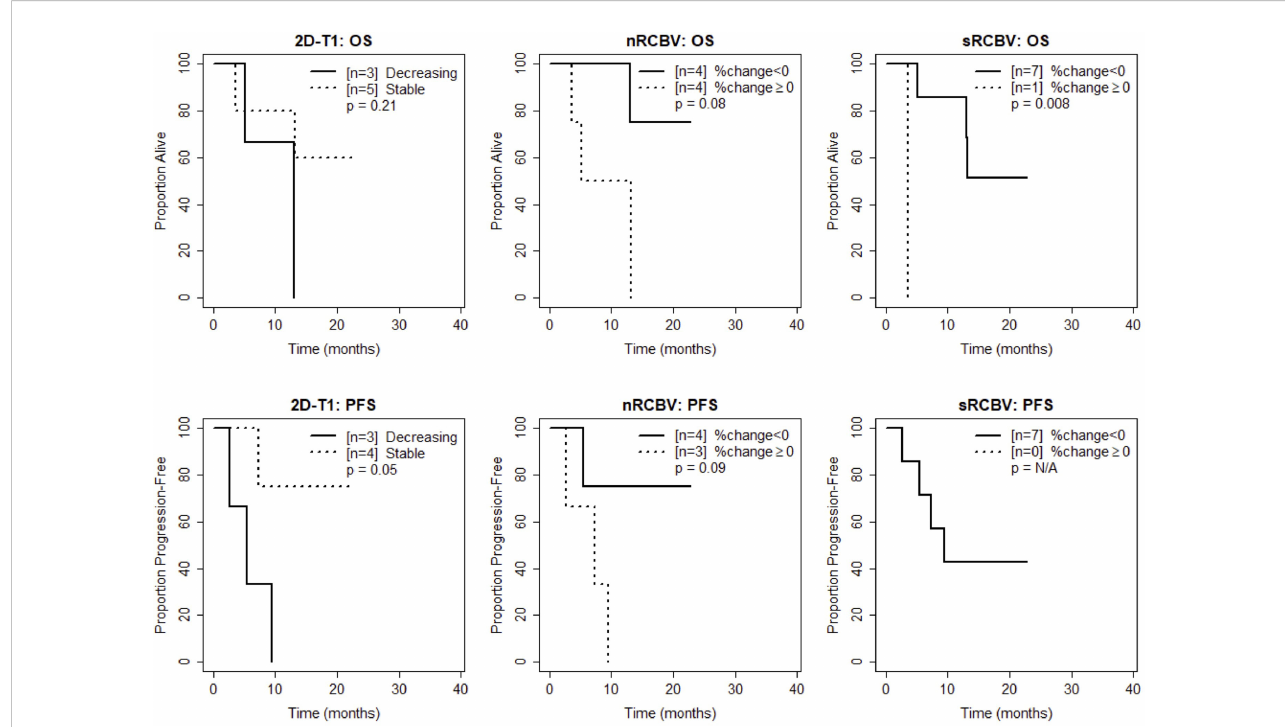
FIGURE 4 Kaplan-Meier curves using week 16 DSC-MRI for time to death (top row) and time to progression or death (bottom row) for T1 non-progressors with stable versus decreasing enhancement on 2D-T1 (left column), T1 non-progressors with decreasing versus increasing normalized rCBV (nRCBV) (middle column), and T1 non-progressors with decreasing versus increasing standardized rCBV (sRCBV) (right column).